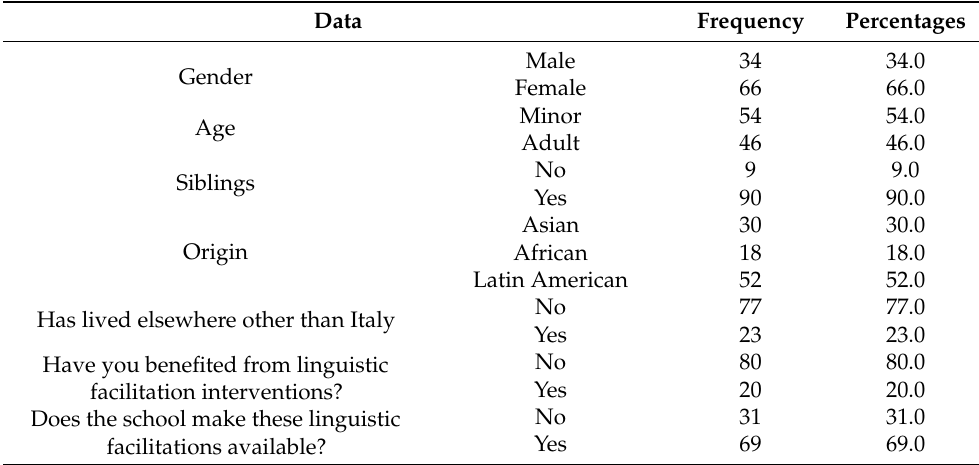
Table 1. Descriptive characteristics of the